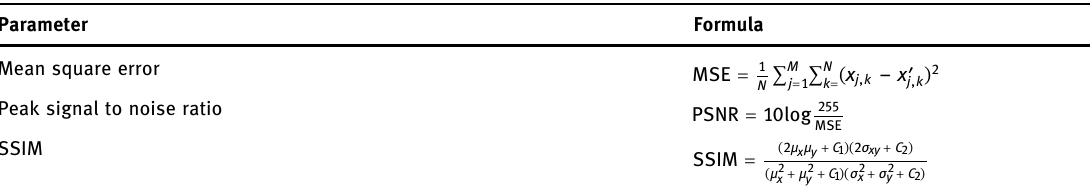
Table 7: Image compression performance analysis Parameter